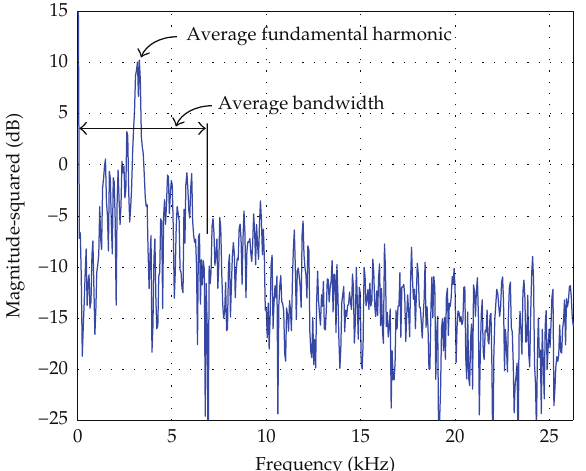
,X 2 (cid:3) . av av